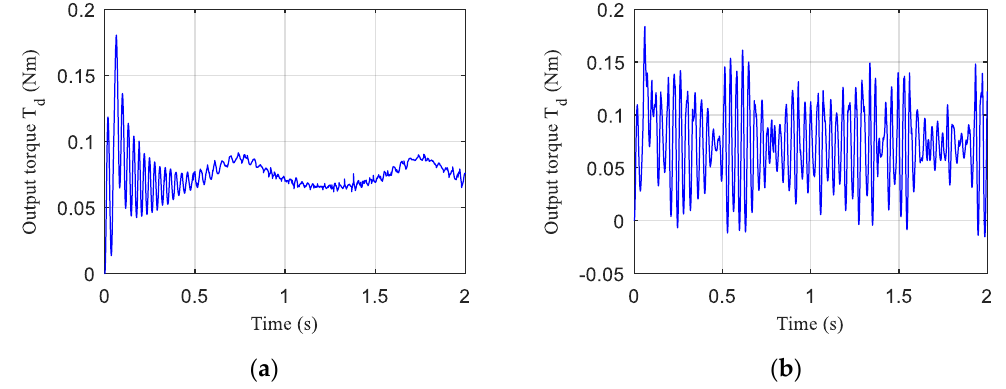
Figure 22. The output torque curve of the stiffness adjustment motor during stiffness tracking. ( a ) The expected joint stiffness is a sine wave signal. ( b ) The expected joint stiffness is a random signal.